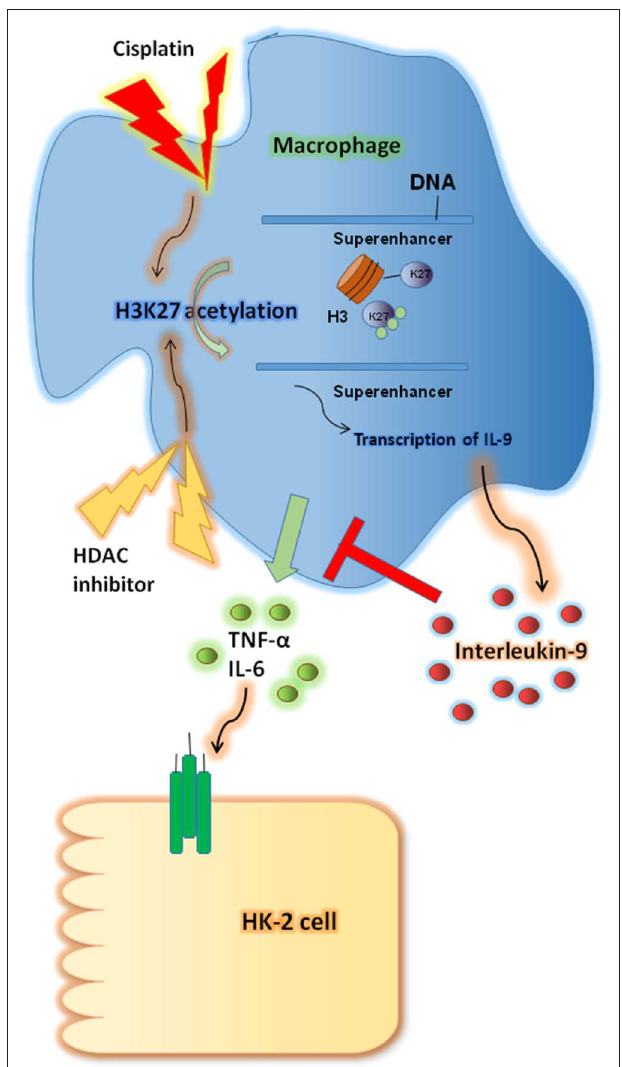
FIGURE 8 | Renoprotective impact of interleukin-9 (IL-9) in cisplatin (CP)-induced acute kidney injury may be attributed to changes in renal function supported a regulatory, anti-inflammatory immune response. IL-9 suppressed pro-inflammatory cytokines such as IL-6 and tumor necrosis factor- α (TNF- α ) associated with macrophages, and H3K27 acetylation promoted IL-9 secretion. Thus, inhibition of H3K27Ac orchestrated IL-9-mediated renoprotection in CP-induced acute kidney